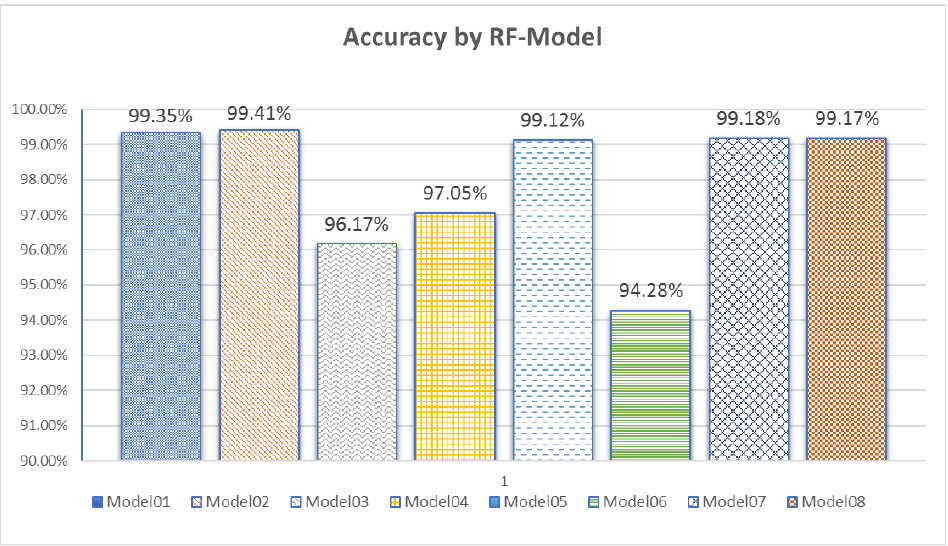
Figure 8. Hit results of RFs’ models with labels created by the eight clustering models.